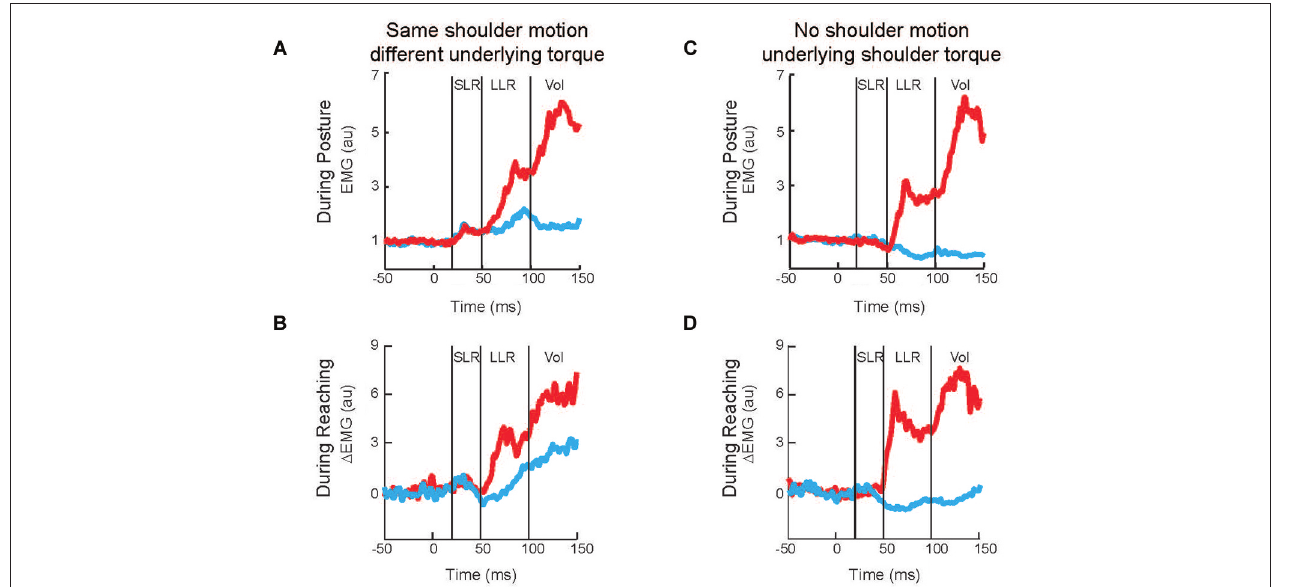
extensor muscle activity evoked by two perturbations during postural maintenance. Red and blue traces denote activity during combined flexor and combined extensor torque perturbations which cause elbow flexion and extension, respectively ( Figures 2E,F ). (D) Group average of shoulder extensor muscle activity evoked by same two perturbations applied during movement initiation; unperturbed pattern of muscle activity has been removed. (A,B) modified with permission from Kurtzer et al. (2008). (C,D) modified with permission from Kurtzer et al.